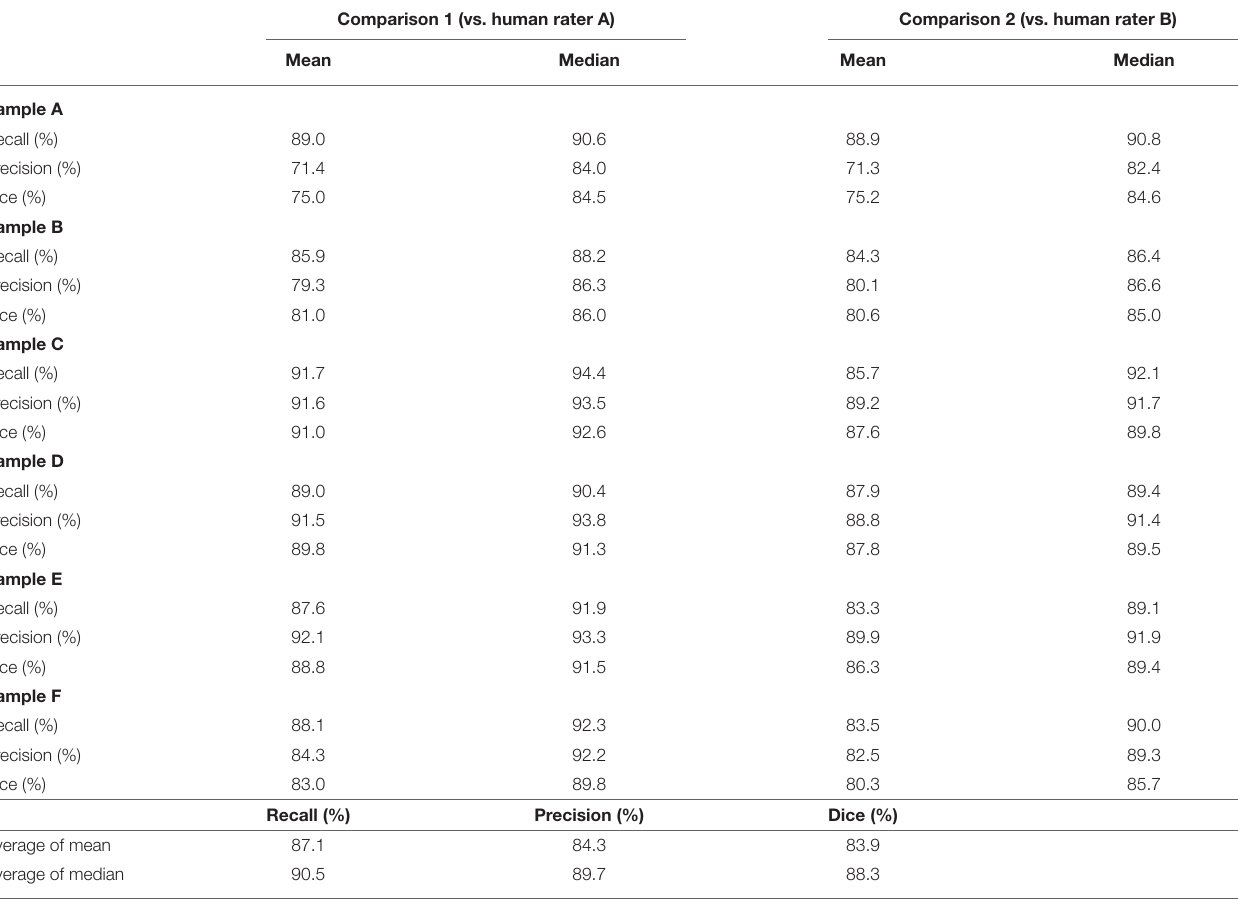
TABLE 2 | Summary of the mean and median of precision, recall, and Dice coefficients (%) upon comparing the stromata contour detection algorithm (SCDA) to human raters A and B for six leaf sample images. Comparison 1 (vs. human rater